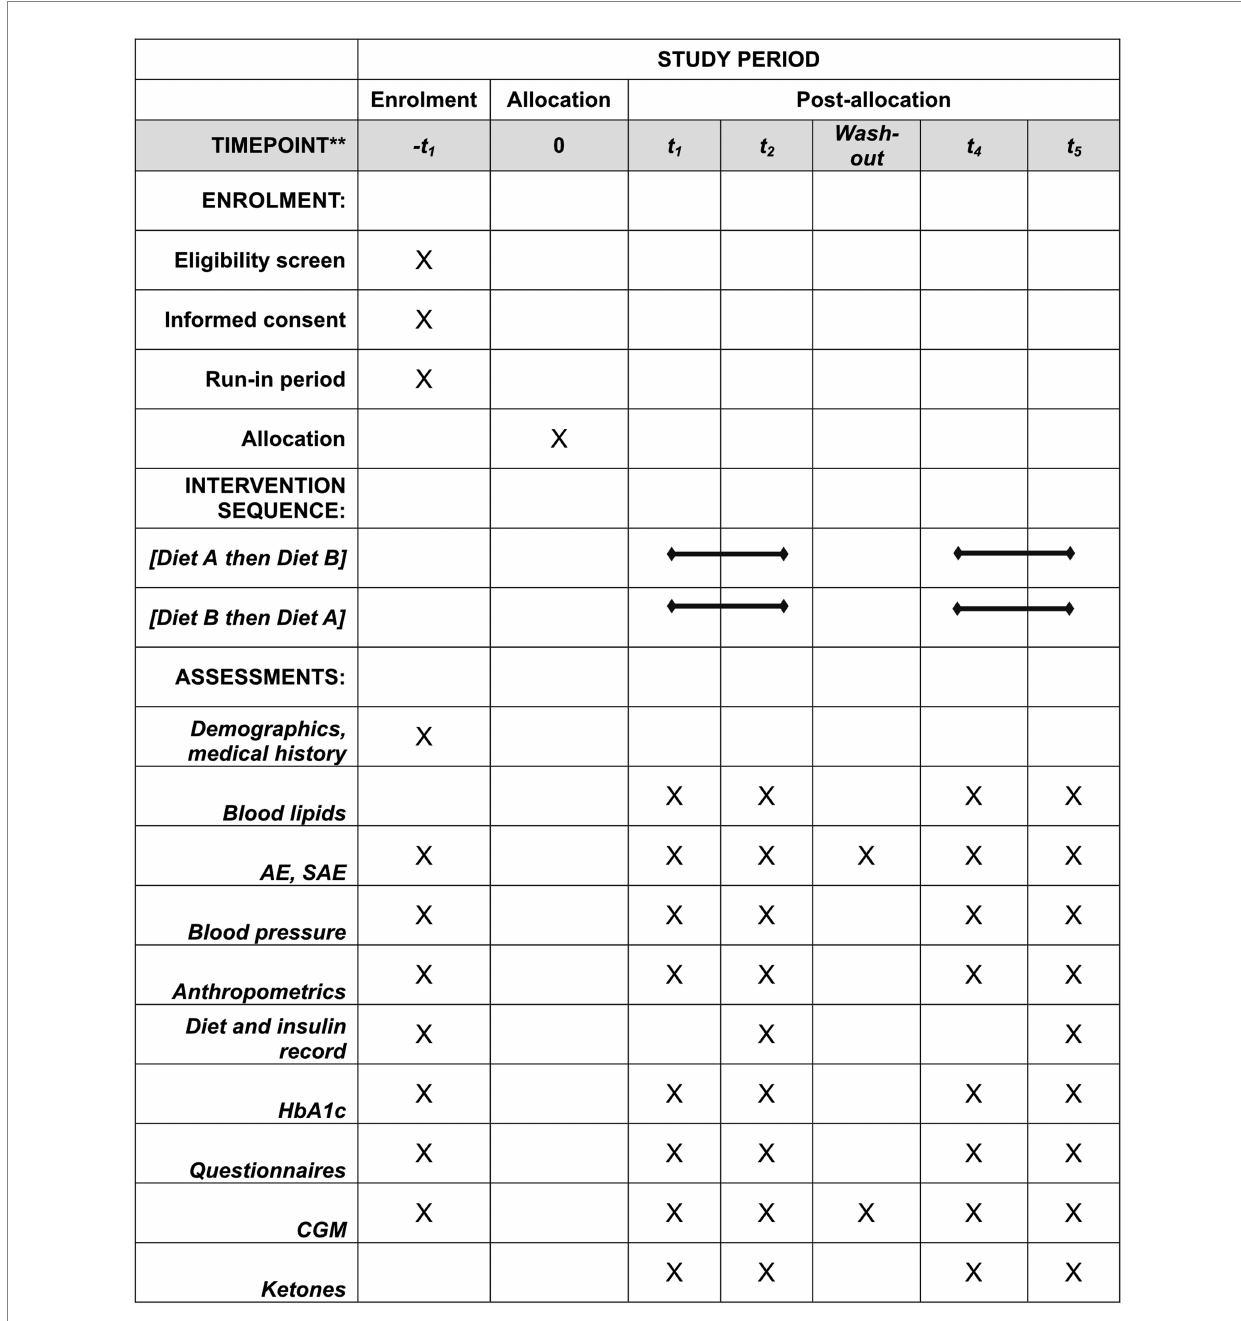
FIGURE 2 Enrolment schedule, interventions, and measurements according to Standard Protocol Items: Recommendations for Intervention Trials (SPIRIT) requirements. AE, adverse event; CGM, continuous glucose monitoring; SAE, severe adverse